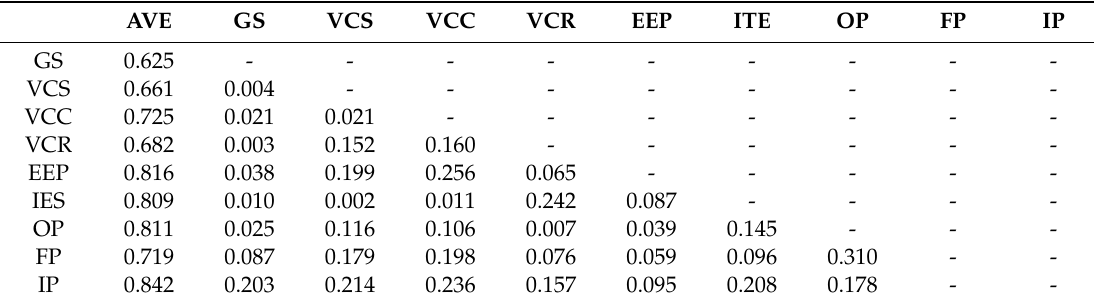
Table 4. Discriminant